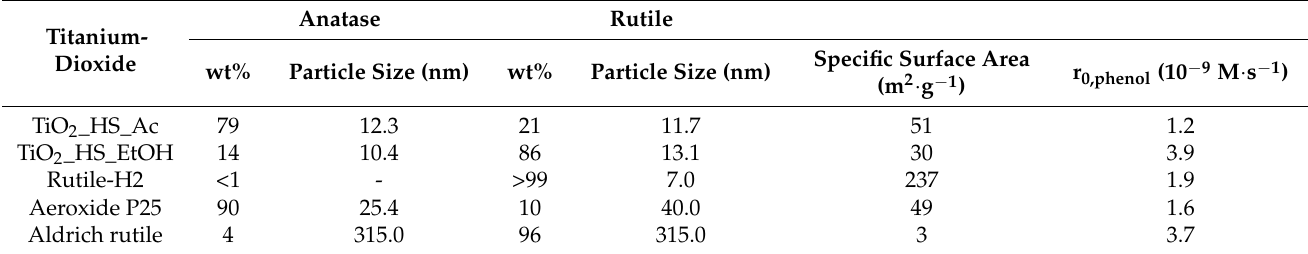
Table 1. Phase composition, average crystallite size, and specific surface area of the investigated titanium dioxides. Titanium-